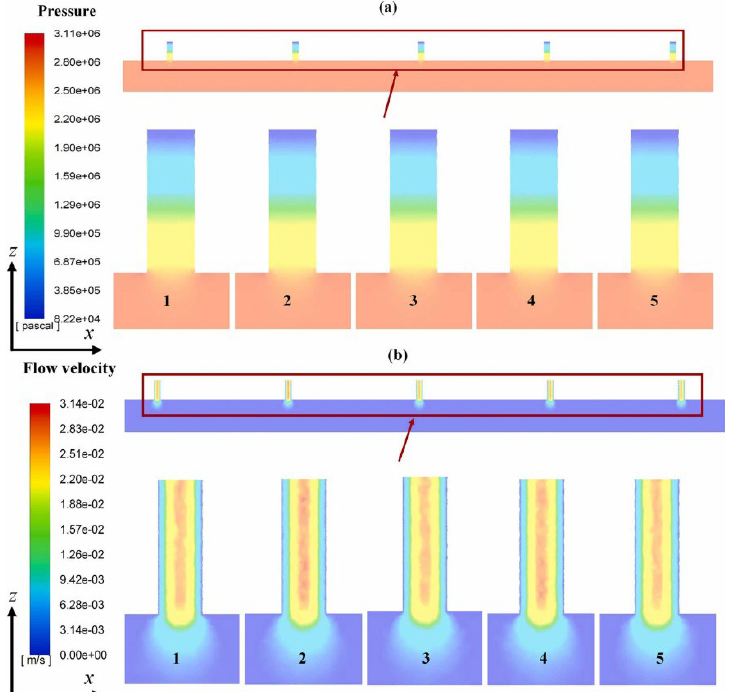
Figure 18. CFD simulation results of ( a ) pressure and ( b ) flow velocity in micro-porous holes [132].